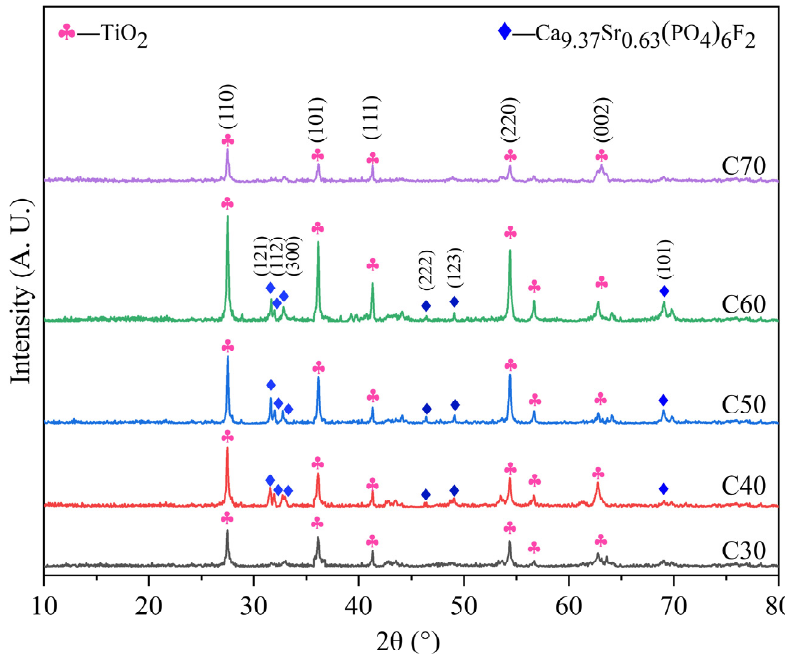
Figure 6. XRD patterns of the calcination products (C30 − C70).